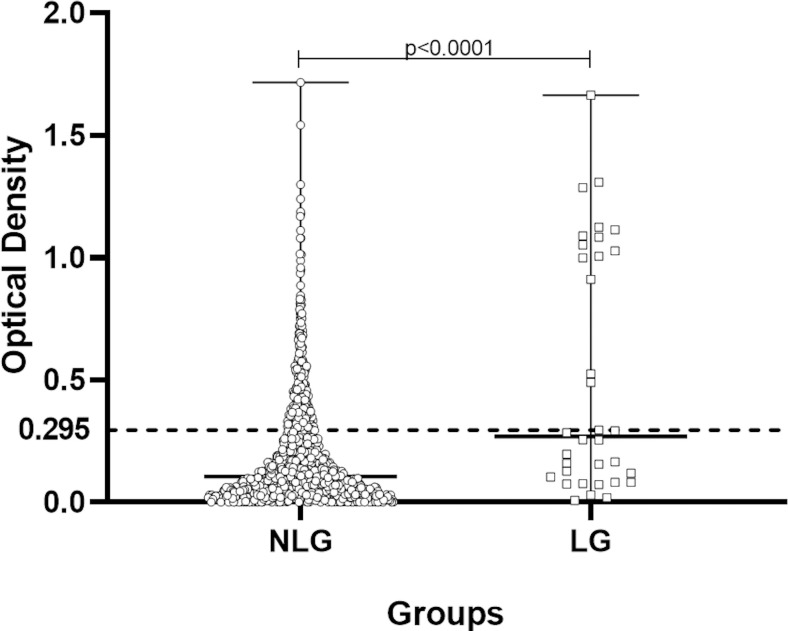
Analysis by optical density (O.D.) of anti-PGL-I ELISA titer of individuals from Non-Leprosy Group and patients from Leprosy Group.